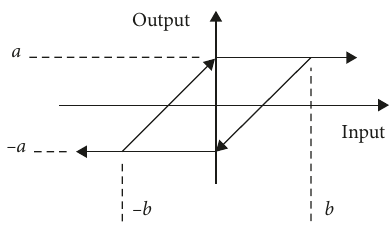
Figure 3: Backlash of hydraulic actuator.